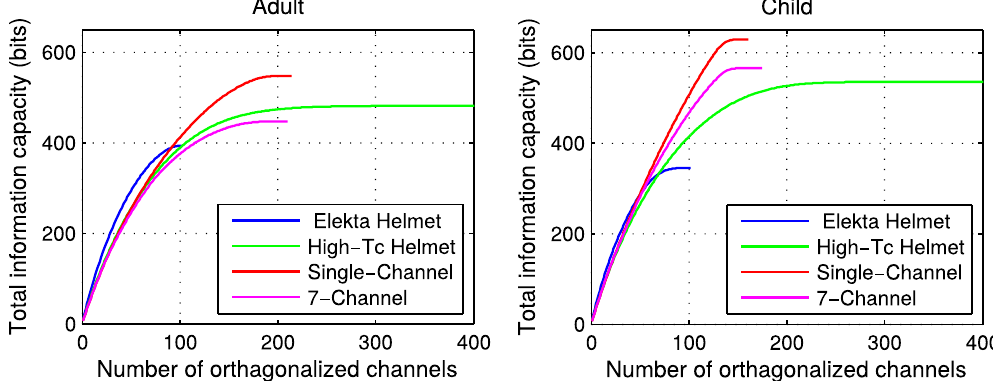
Figure 1. Cumulative sum of information capacity for Elekta and high- T c SQUID arrays as they sample the adult (left) and child (right) brains. The high- T c SQUID noise level used here is conservative (50 fT/ √ Hz) whereas the Elekta SQUID noise is 3 fT/ √ Hz. Only the first 400 orthogonal channels are presented because the cumulative information does not increase significantly beyond that. In the adult case, the slope for the Elekta system is higher than all high- T c arrays. In the child case, the upward trend is similar for all arrays. In all cases, the total information available to the high- T c arrays is higher than the Elekta system.